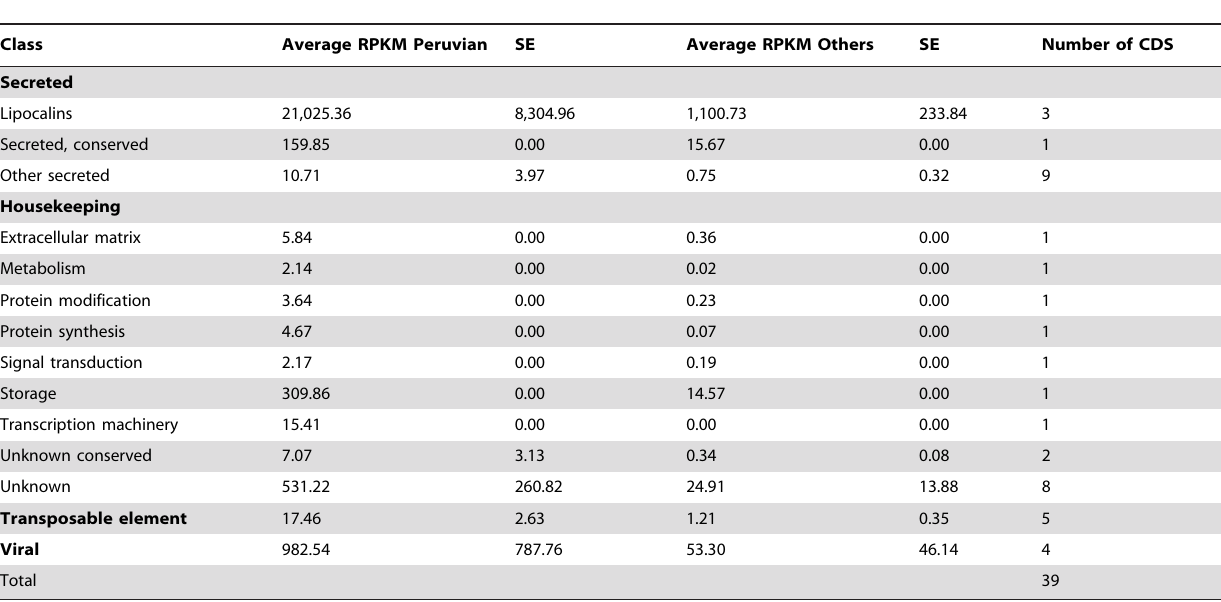
Table 11. Transcripts found overexpressed ( . 10 fold) on Peruvian population.